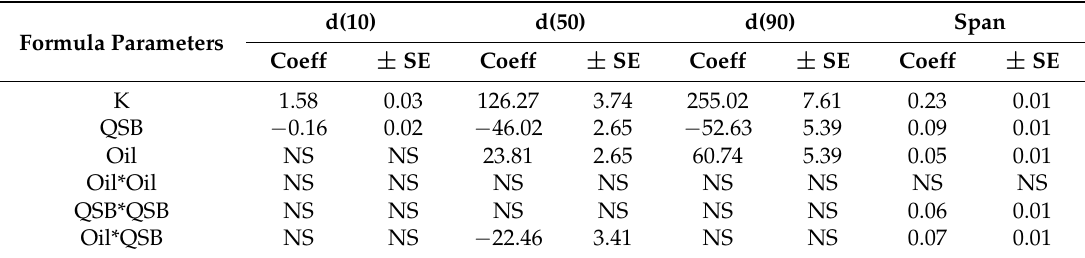
Table 5. Summary of regression analysis results for measured responses (central composite design), for formula optimization. Formula